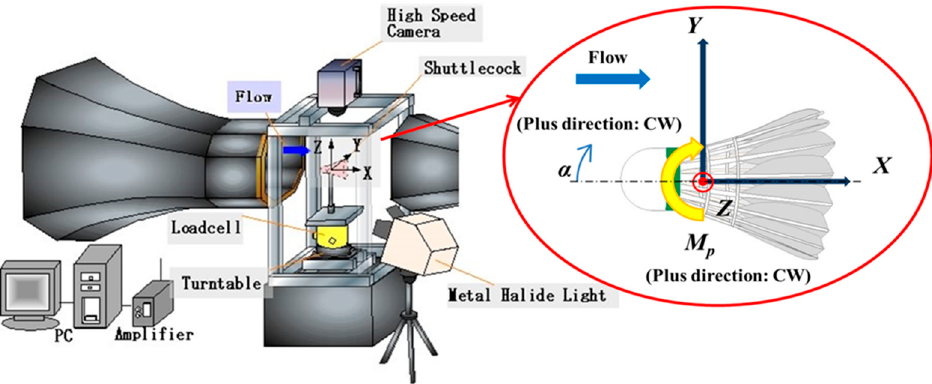
Figure 1. An overview of the wind tunnel experimental